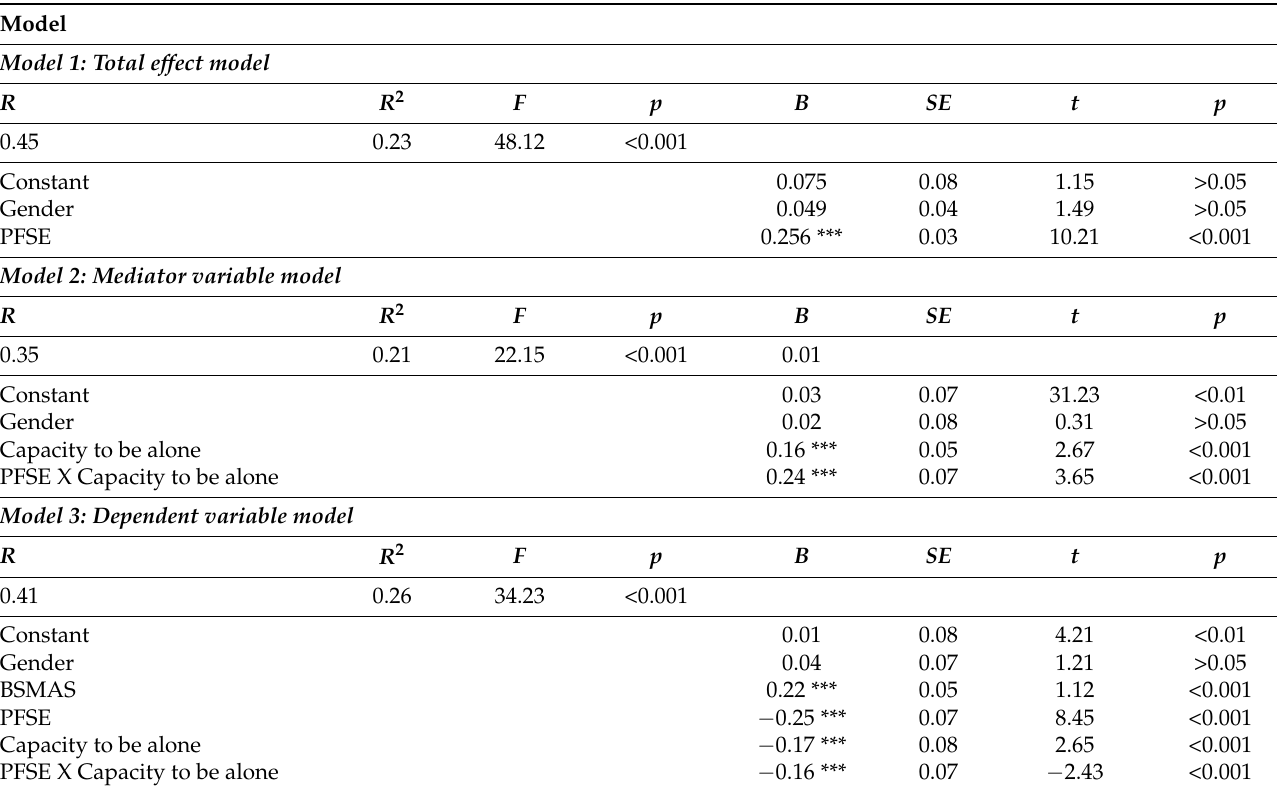
Table 2. Regression and moderated mediation